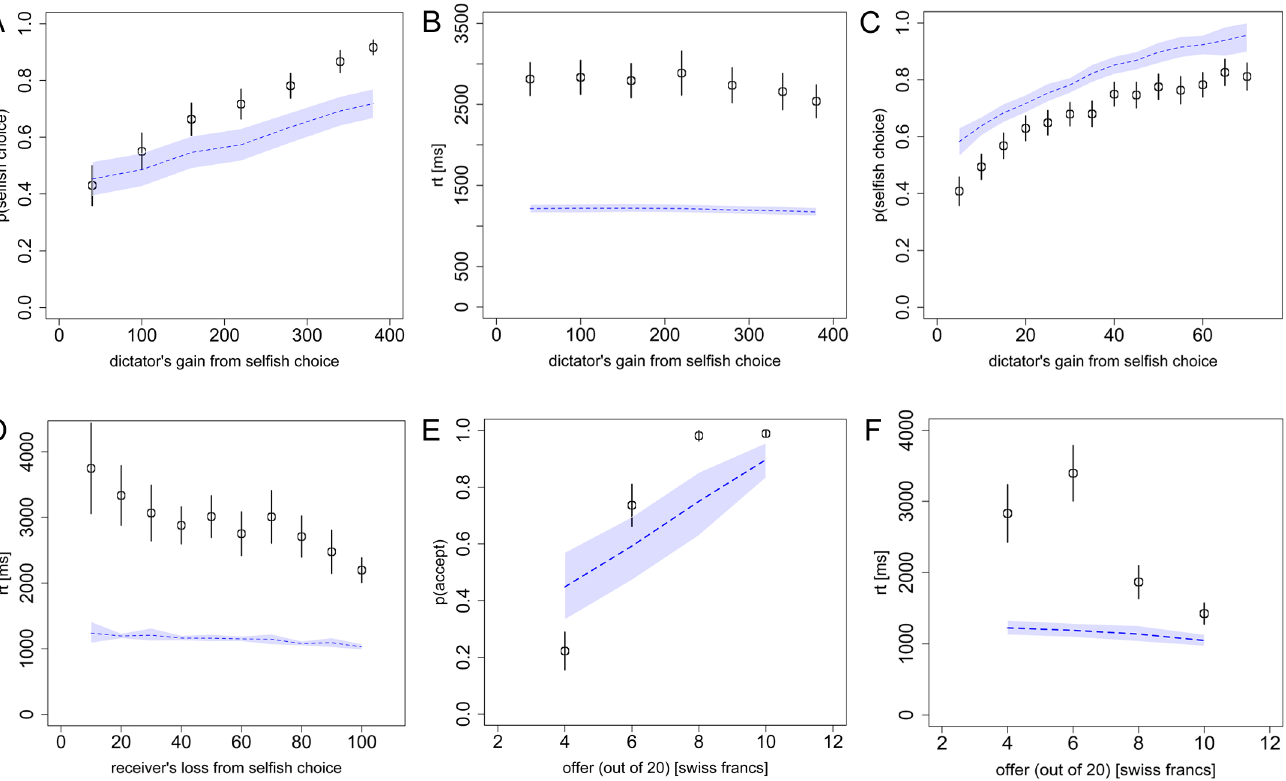
Fig 8. Alternative sequential sampling model. A) Replication of Fig 2A, B) Fig 2B, C) Fig 3A, and D) Fig 4C, E) Fig 5A, and F) Fig 5B, using the alternative Ornstein-Uhlenbeck model. Black circles indicate the aggregate subject data with bars representing s.e.m. Dashed lines indicate the alternative model predictions with 95% confidence